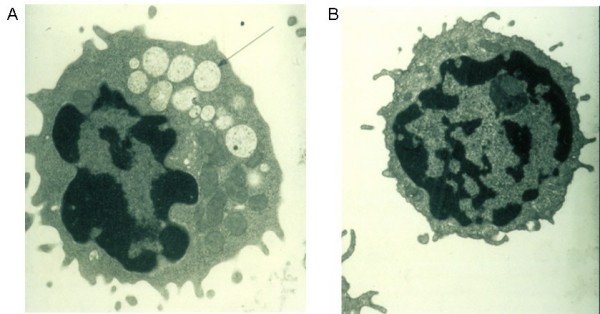
Electron micrograph of a vacuolated lymphocyte. Electron micrograph of a vacuolated lymphocyte from a mannosidosis patient (A) as compared to a lymphocyte from a normal control (B).